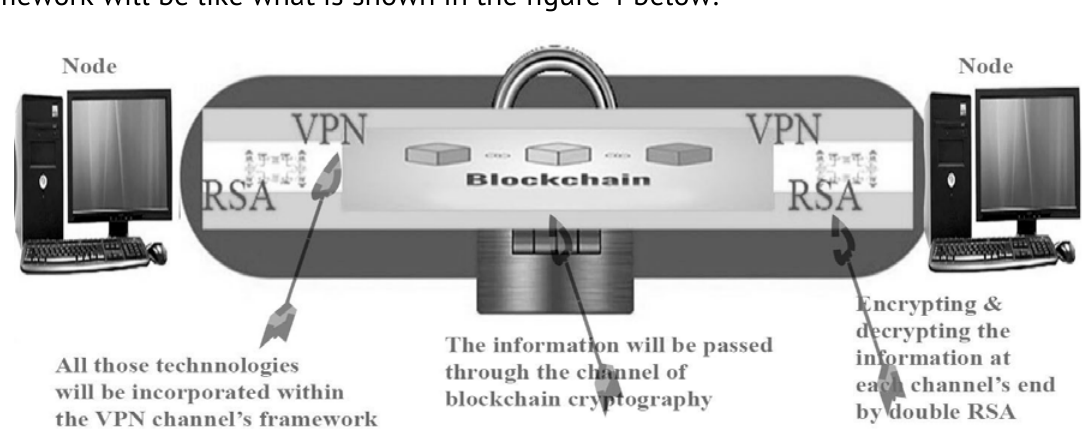
Figure 4. The architecture of Hydra suite containing the proposed